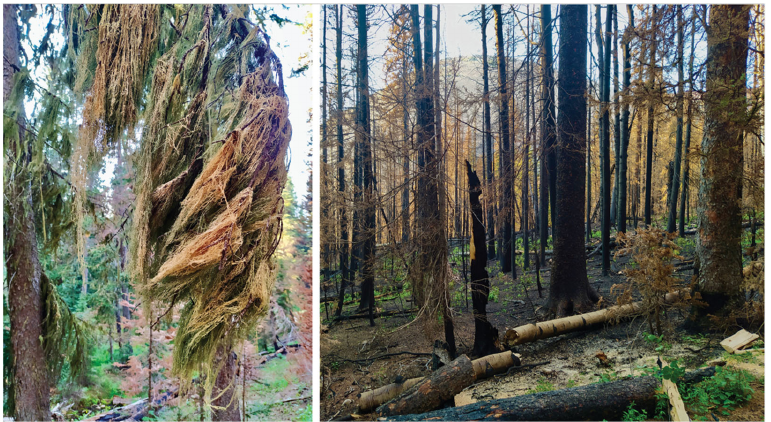
Figure 5. Fire damage to fruticose lichen communities near the headwaters of Mill Creek in the La Sal Mountains in southern Utah, USA.